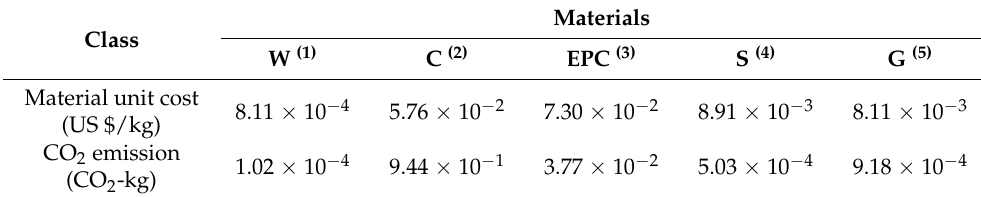
Table 7. Data of the material unit costs and CO 2